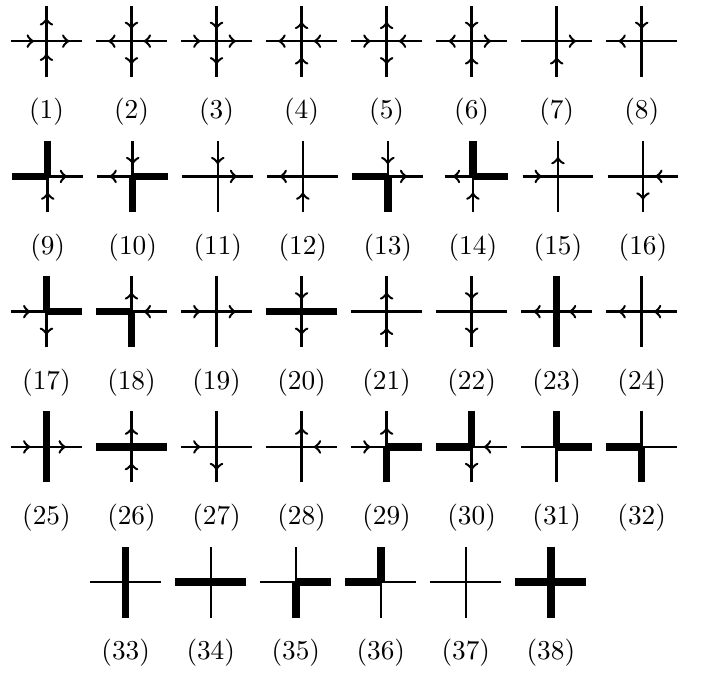
Figure 6 . The 38 vertices of the D 2